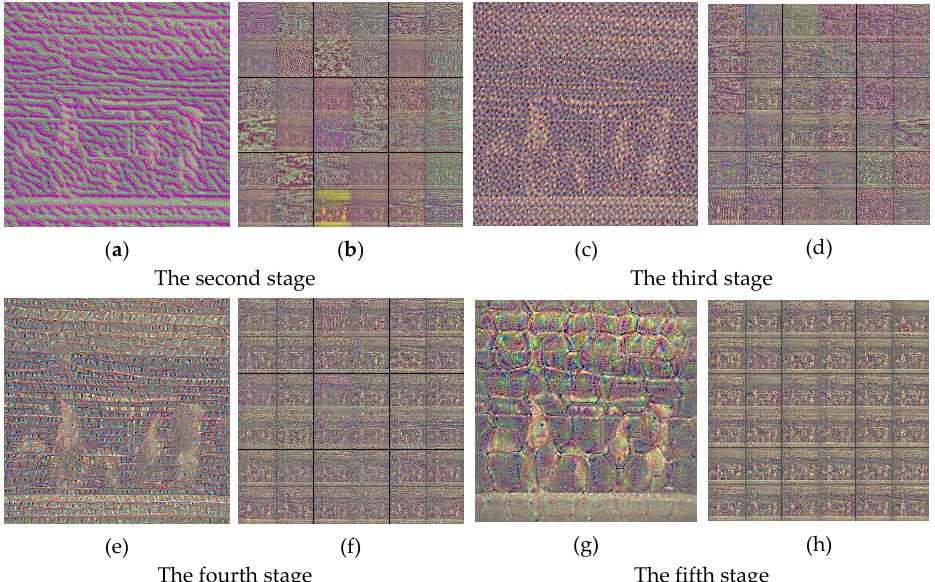
Figure 8. Convolution kernel visualization results. ( a , c , e , g ) are the visualization result of the first convolution kernels at each stage, respectively. ( b , d , f , h ) are the visualization results of the first 36 convolution kernels at each stage, respectively.